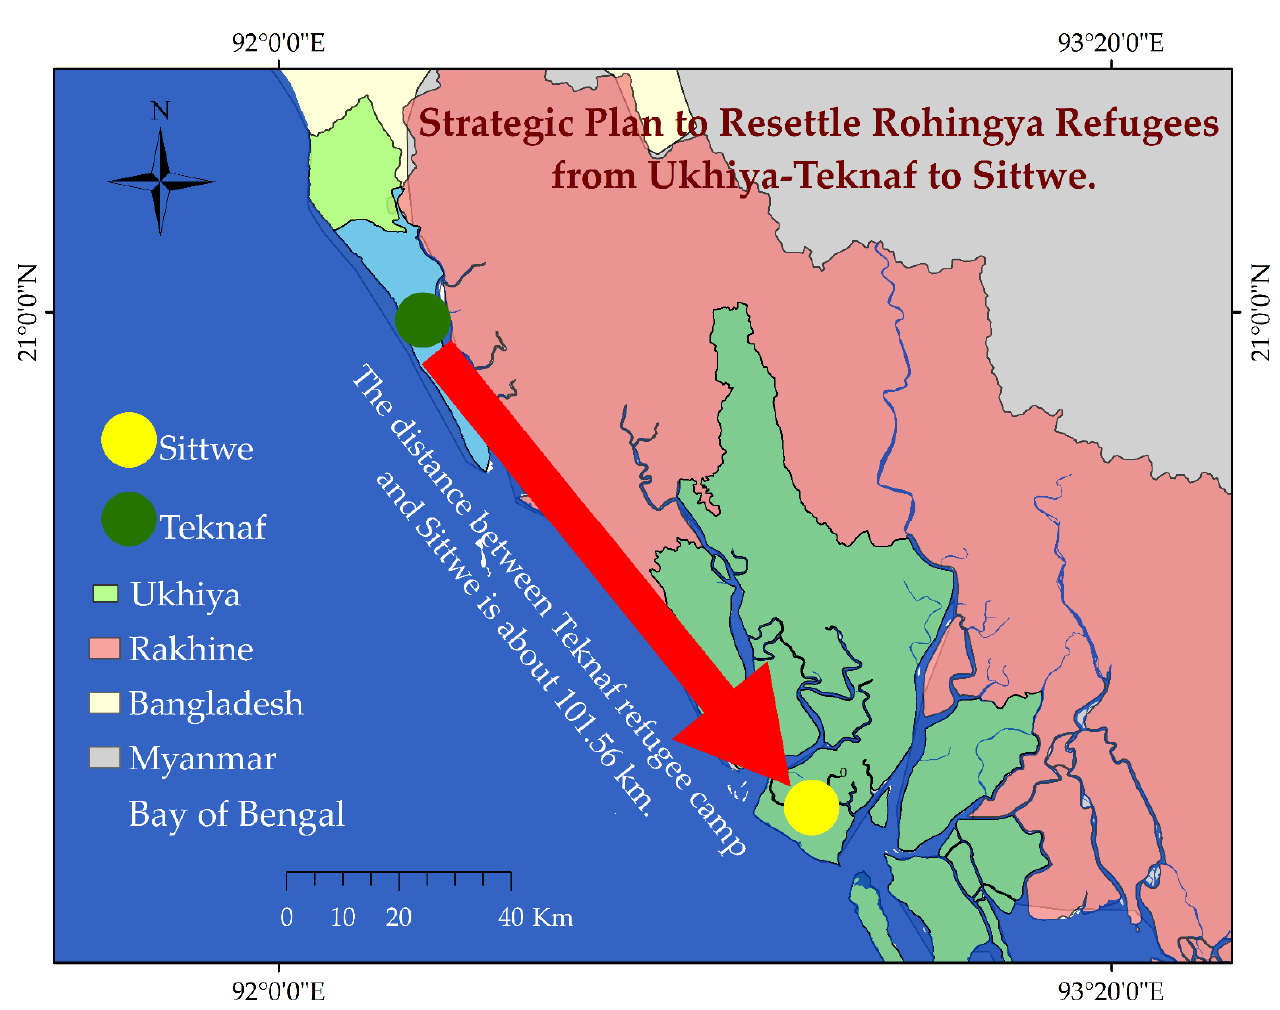
Figure 17. Strategic proposal to relocate Rohingyas from the densely populated refugee camps of Ukhiya and Teknaf to the capital of Rakhine state, Sittwe.